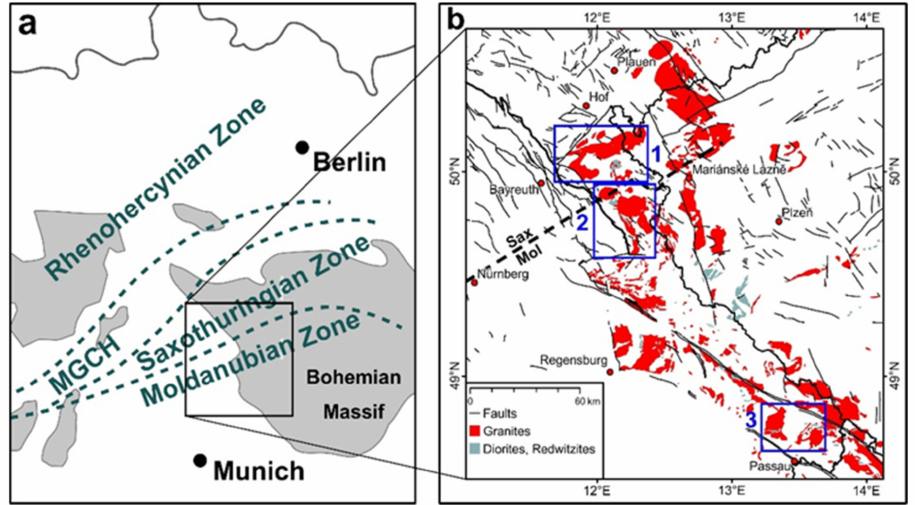
Figure 1. Location of the sampling sites from the Bohemian Massif. Region 1—Fichtelgebirge; region 2—Oberpfalz; region 3—Bavarian